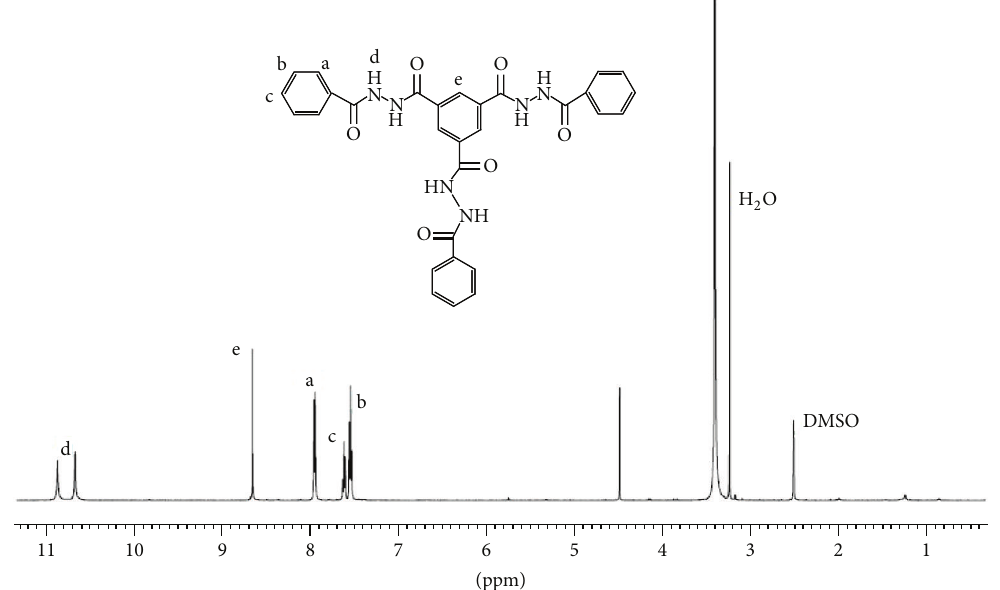
Figure 2: 1 H NMR spectrum of TTAD.